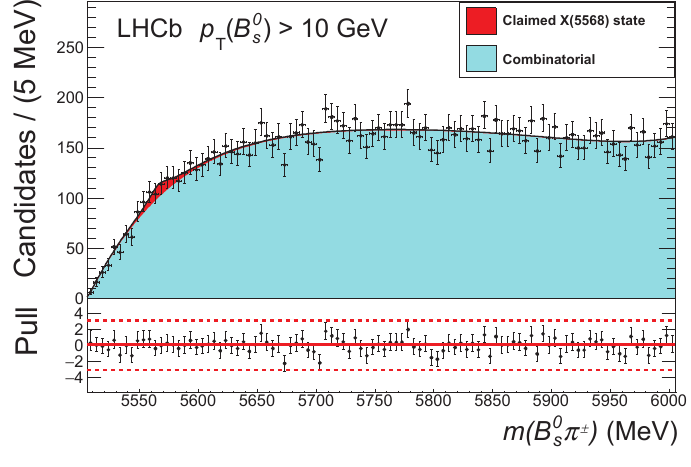
π ± spectrum showing no signi fi cant excess at the X (5568) mass for Figure 4. Fit to the B 0 s p T ( B 0 ) > 10 GeV. Figure adopted from s